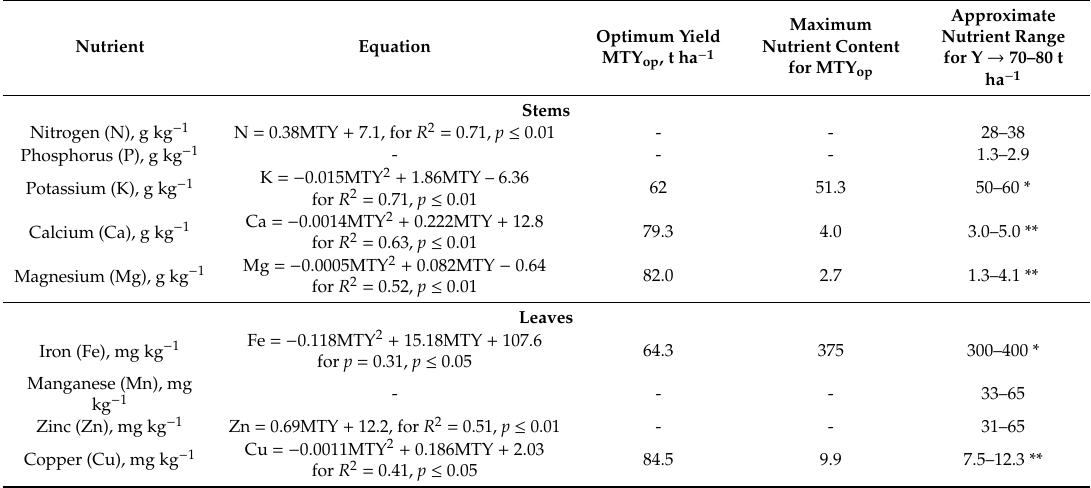
Table 7. Approximate nutrient standards for high-yielding potato based on nutrient content in stems at BBCH 39 / 40. ( n =